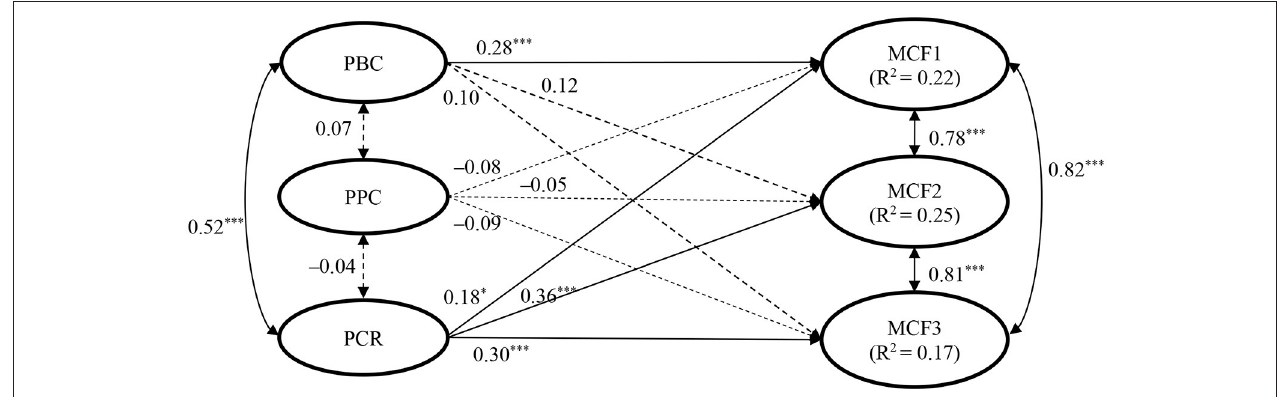
FIGURE 2 | Standardized results of structural equation modeling on the relationships between parental factors and adolescent moral character in Study 2. Child age and gender, parent age and gender, family intactness, and family economic status were controlled. The control variables, observed indicators, and residuals were not shown in the figure. PBC, parental behavioral control; PPC, parental psychological control; PCR, parent–child relationship; MCF1, moral character factor 1 (i.e., treating others well); MCF2, moral character factor 2 (i.e., self-discipline and law-abidance); MCF3, moral character factor 3 (i.e., traditional Chinese virtues). χ 2 = 1797.224, df = 955, χ 2 /df = 1.88, CFI = 0.868, NNFI = 0.858, RMSEA = 0.048, SRMR = 0.061. * p < 0.05; *** p <